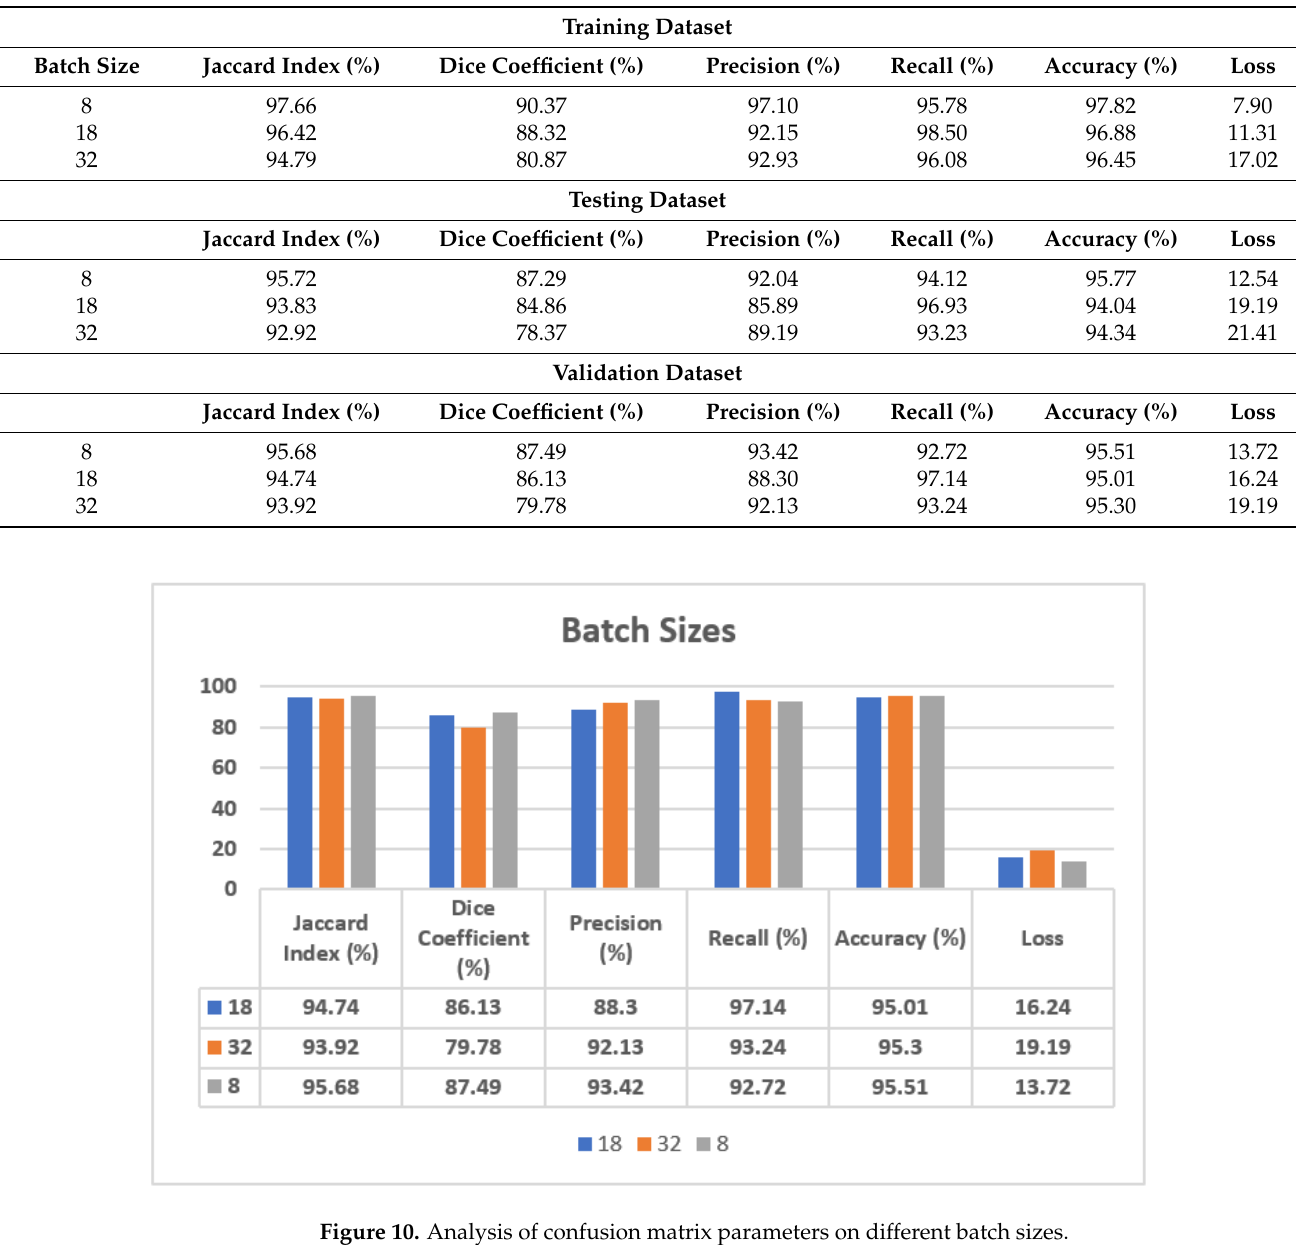
Figure 10. Analysis of confusion matrix parameters on different batch sizes.